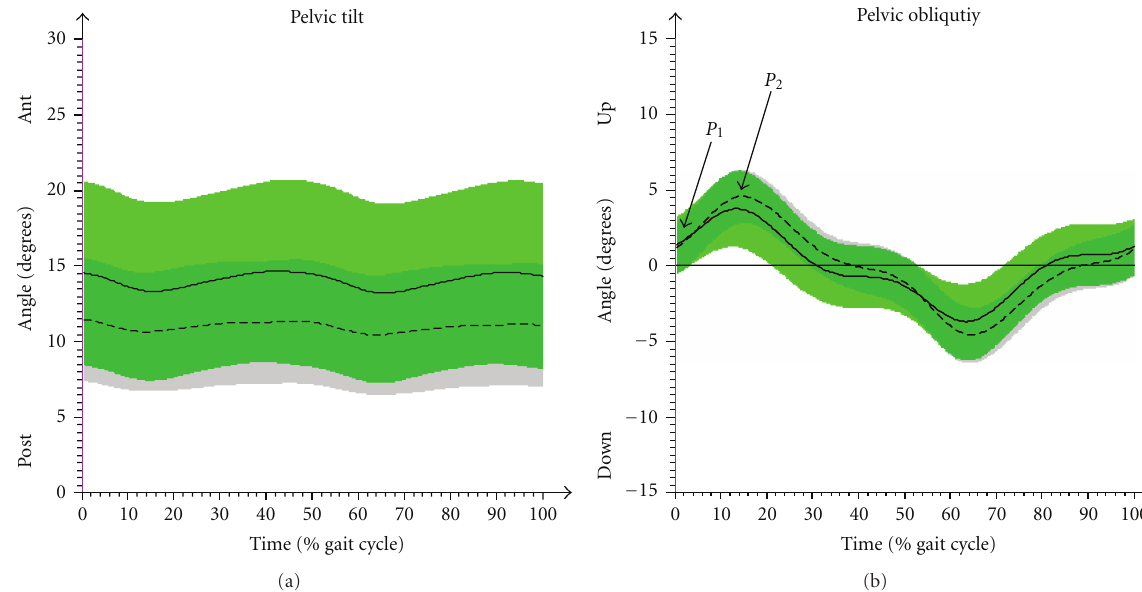
Figure 3: Comparison of angle progression in the pelvic tilt (a) and obliquity (b). CG (arithmetic mean & SD (---)); JIA-P (arithmetic mean and SD (—)). P 1 (initial contact) and P 2 (max. increase in loading response) are the points of interest in the pelvic